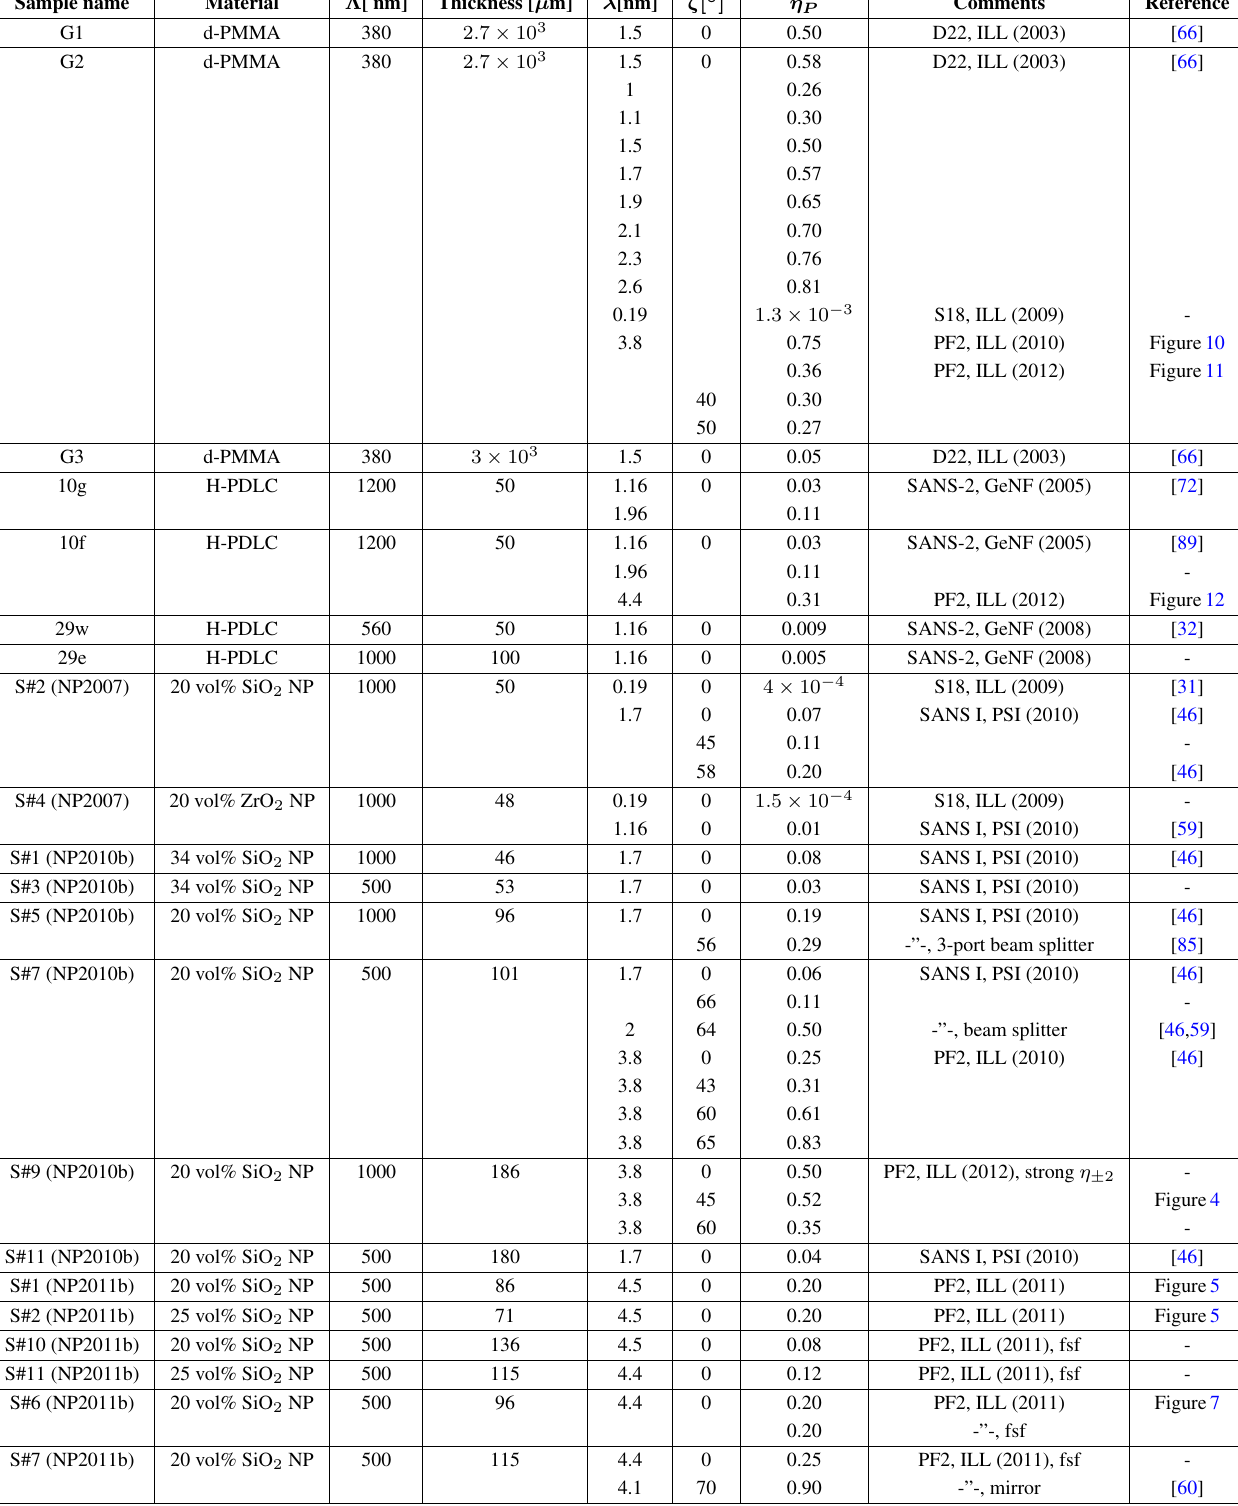
Table 1. Summarized results of neutron experiments with holographic gratings. Missing entries refer to the entry in the preceding line of the same column. The thickness is the mechanical thickness. “fsf” corresponds to free-standing film samples. “GeNF” refers to the (recently closed) Geesthacht Neutron Facility,